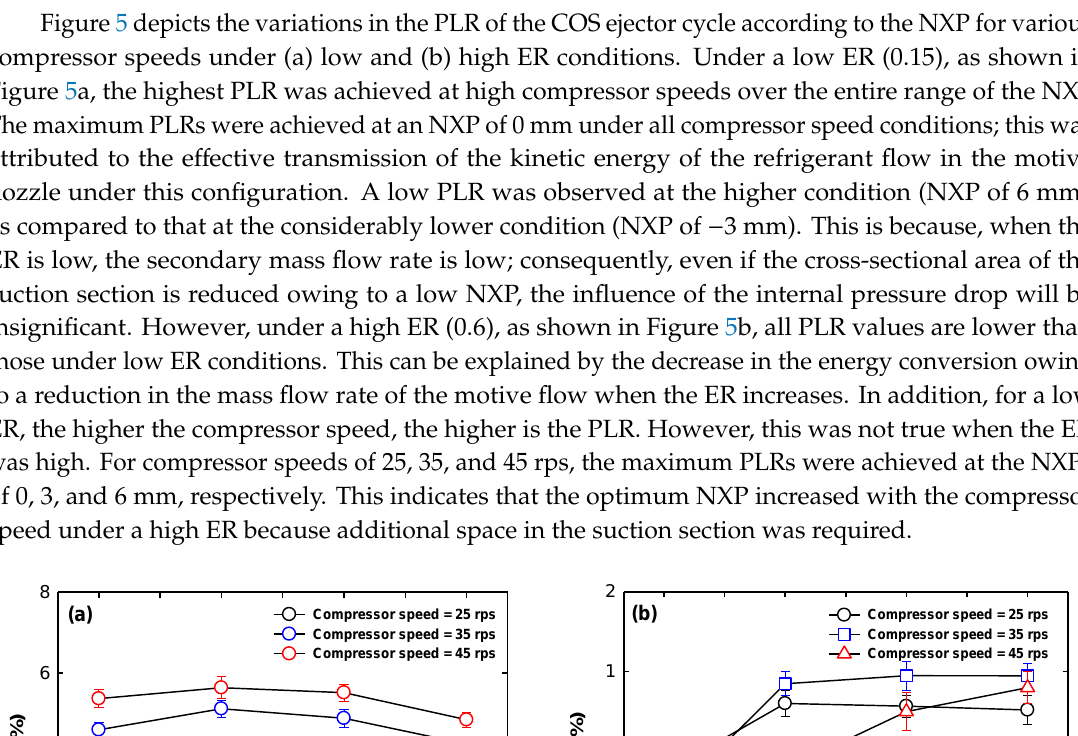
Figure 5. Variations in PLR according to NXP for various compressor speeds at an ER of ( a ) 0.15